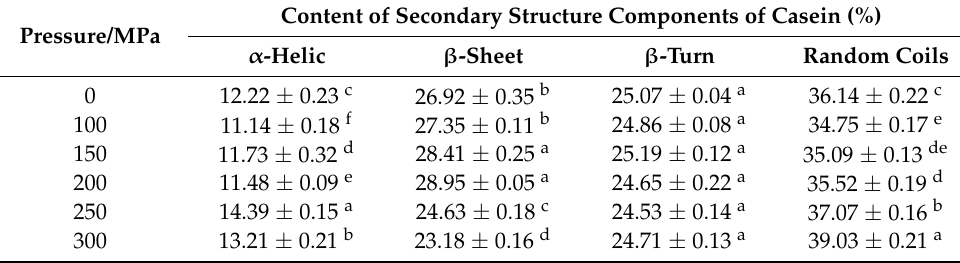
Table 2. Content of secondary structural components of casein under different pressure conditions.